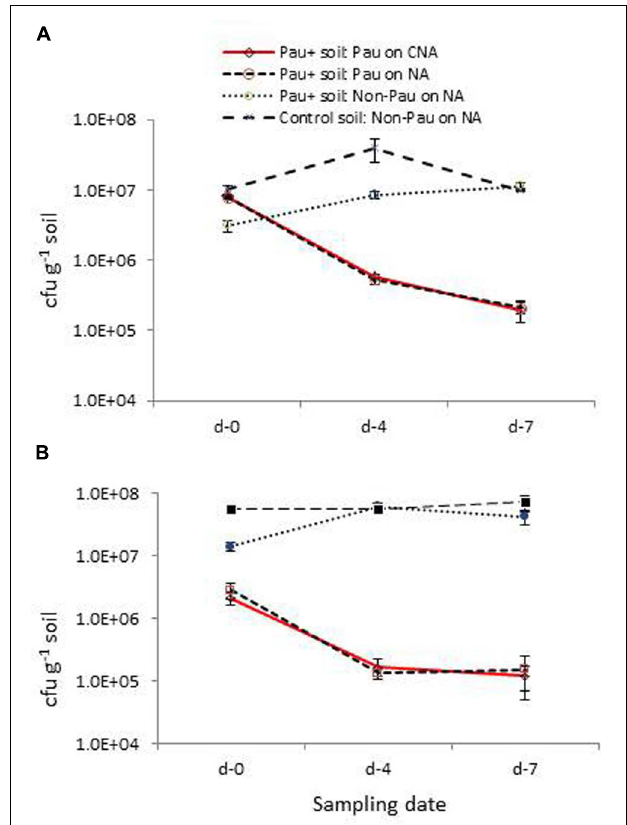
FIGURE 7 | Validation trials employing fresh field soil (A) and micro-flora stabilized banana rhizospheric soil (B): extent of P. aeruginosa ( Pau ) and non- Pau organisms in potted Pau -inoculated ( Pau + ) and control ( Pau − ) field soils on different sampling dates commencing from the date of Pau application (day-0) as per the cfu estimations on CNA and NA (cumulative of cfu recorded on day-1 to day-4; vertical bars indicate standard